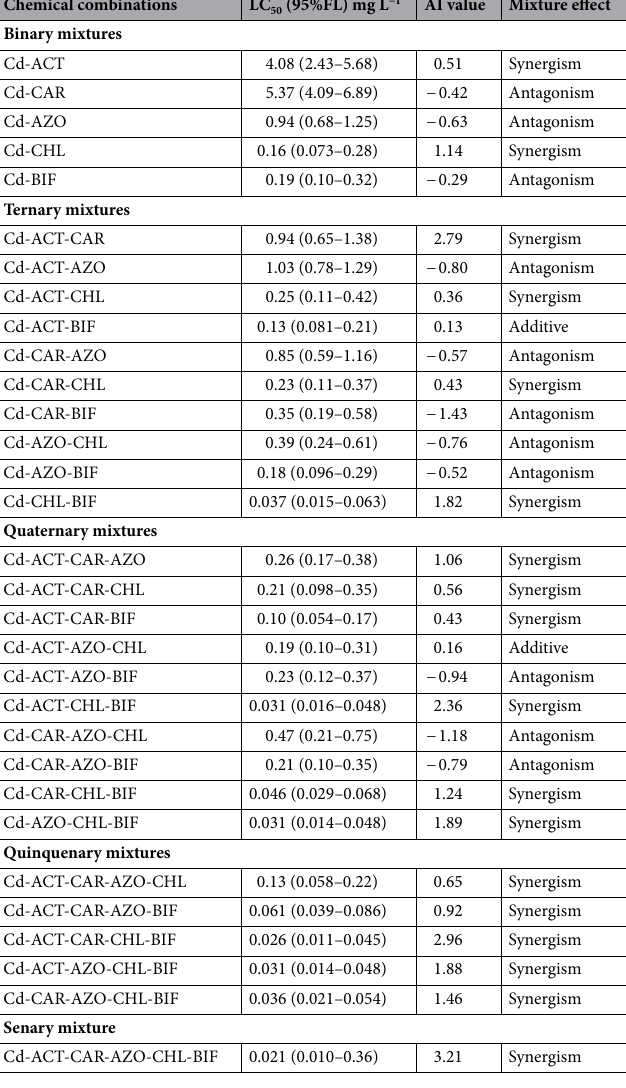
Table 2. Mixture toxicity of Cd and five pesticides with equivalent concentration to the larvae of D. rerio . FL fiducial limit, AI additive index, ACT acetamiprid, CAR carbendazim, AZO azoxystrobin, CHL chlorpyrifos, BIF